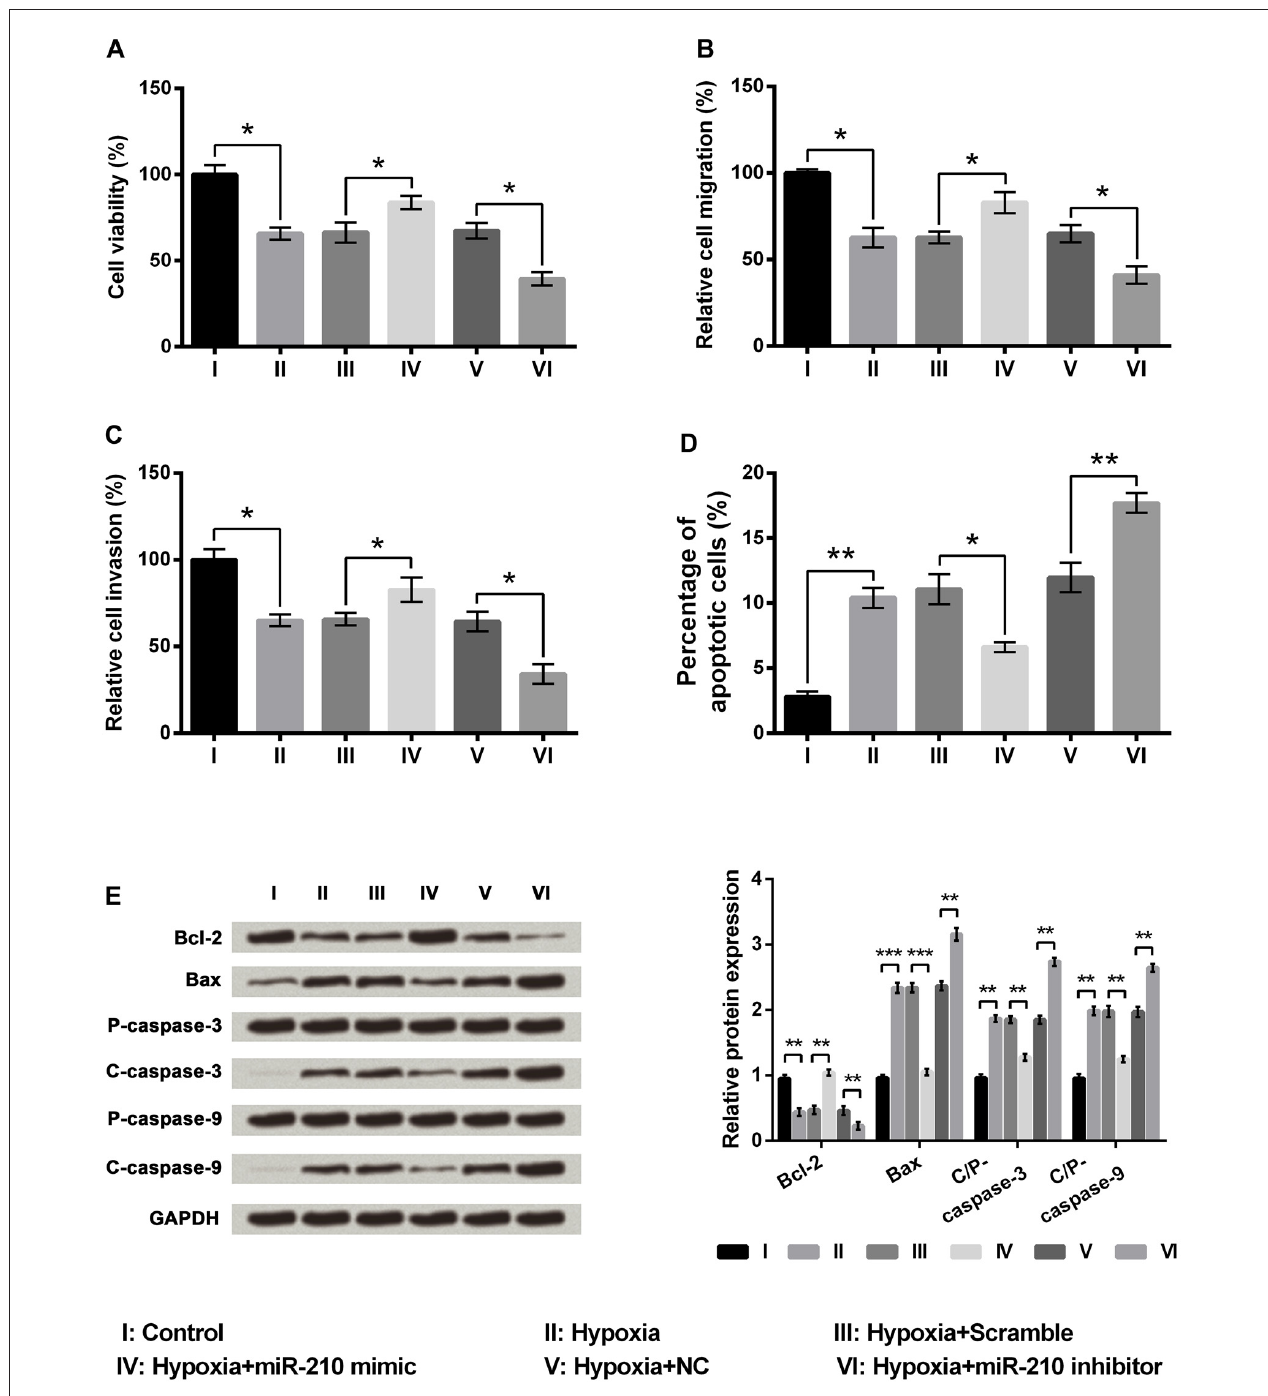
FIGURE 4 | MicroRNA (miR)-210 overexpression alleviated the injury induced by hypoxia in PC-12 cells. (A–D) Overexpression of miR-210 increased cell viability, cell migration, cell invasion, and decreased cell apoptosis. (E) Western blotting analysis of apoptosis related factors. Data presented are the mean ± SEM of at least three independent experiments. ∗ P < 0.05; ∗∗ P < 0.01; ∗∗∗ P < 0.001. Bcl-2, mammalian B cell lymphoma-2; Bax, Bcl-2-associated X protein; C/P-, cleaved/pro; NC, negative control of miR-210 inhibitor.